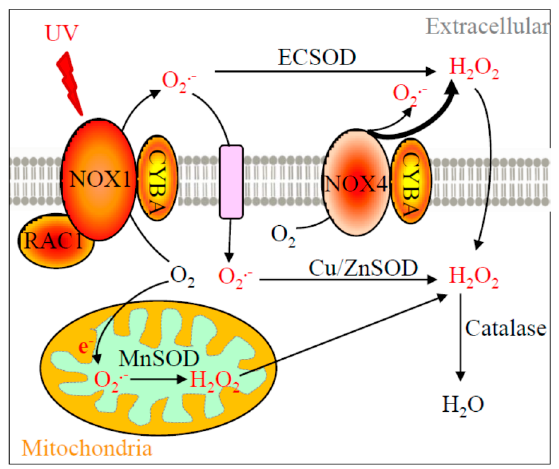
Figure 1. Diagram of the relevant reactive oxygen species (ROS) production pathway. NOX1, NOX4, CYBA, RAC1, SOD enzymes, catalase, their subcellular locations, and their functions in ROS production and metabolism are depicted in this diagram. NOX1 enzyme complex utilizes CYBA as one of its subunits and is activated by RAC1-GTPase to produce superoxide. On the other hand, NOX4 only couples with CYBA to generate hydrogen peroxide and superoxide. Of particular note, only plasma membrane NOX4 is shown in this diagram but mitochondrial or nuclear NOX4 has also been reported [16]. NOX1 is activated by UV to enhance its superoxide production, which requires the GTPase activity of RAC1. Superoxide is further metabolized into hydrogen peroxide at various subcellular locations by different SOD isozymes. Hydrogen peroxide is then converted into water molecules by catalase. Other additional redox enzymes (e.g., glutathione peroxidases, which also convert hydrogen peroxide into water) are not the focus in this study and therefore not included. Black arrows indicate the cellular movement of oxygen, ROS, and enzymatic metabolisms. A bold arrow represents a greater relative amount of ROS produced.